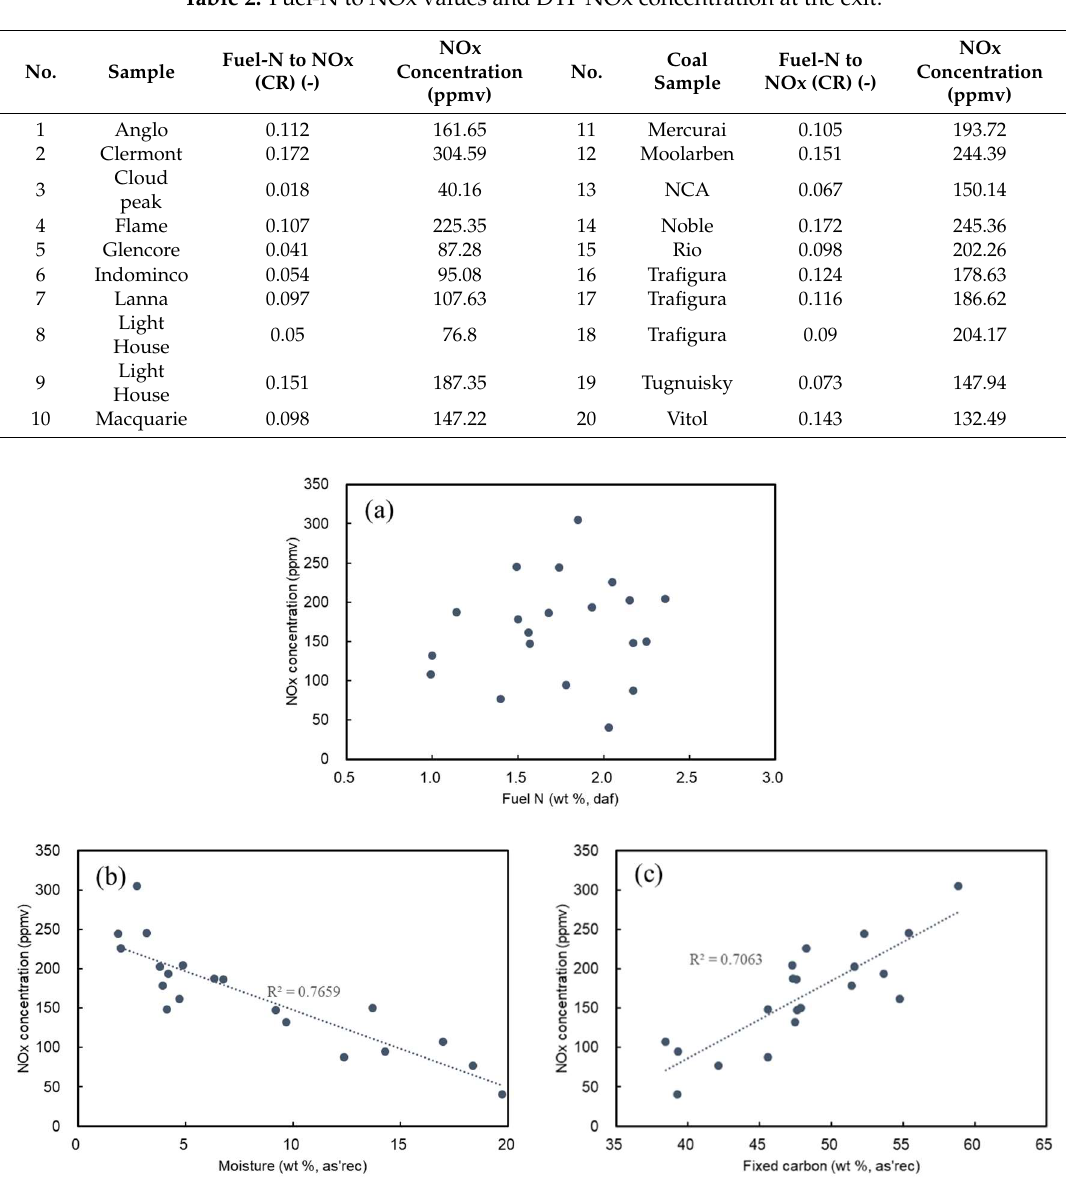
Figure 3. Relation between NOx concentration and fuel-N (a), moisture (b), and fixed carbon (c).